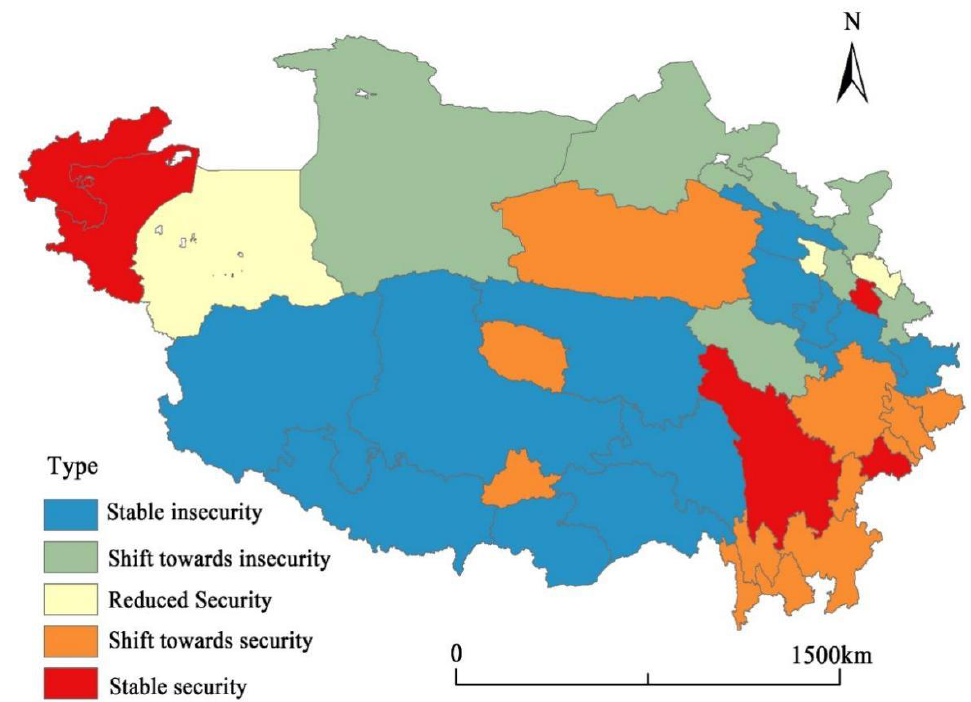
Figure 9. Transformation of the Economic Security Types of Prefecture-level Cities in Qinghai – Tibet Plateau in 2000 and 2019. Plateau in 2000 and